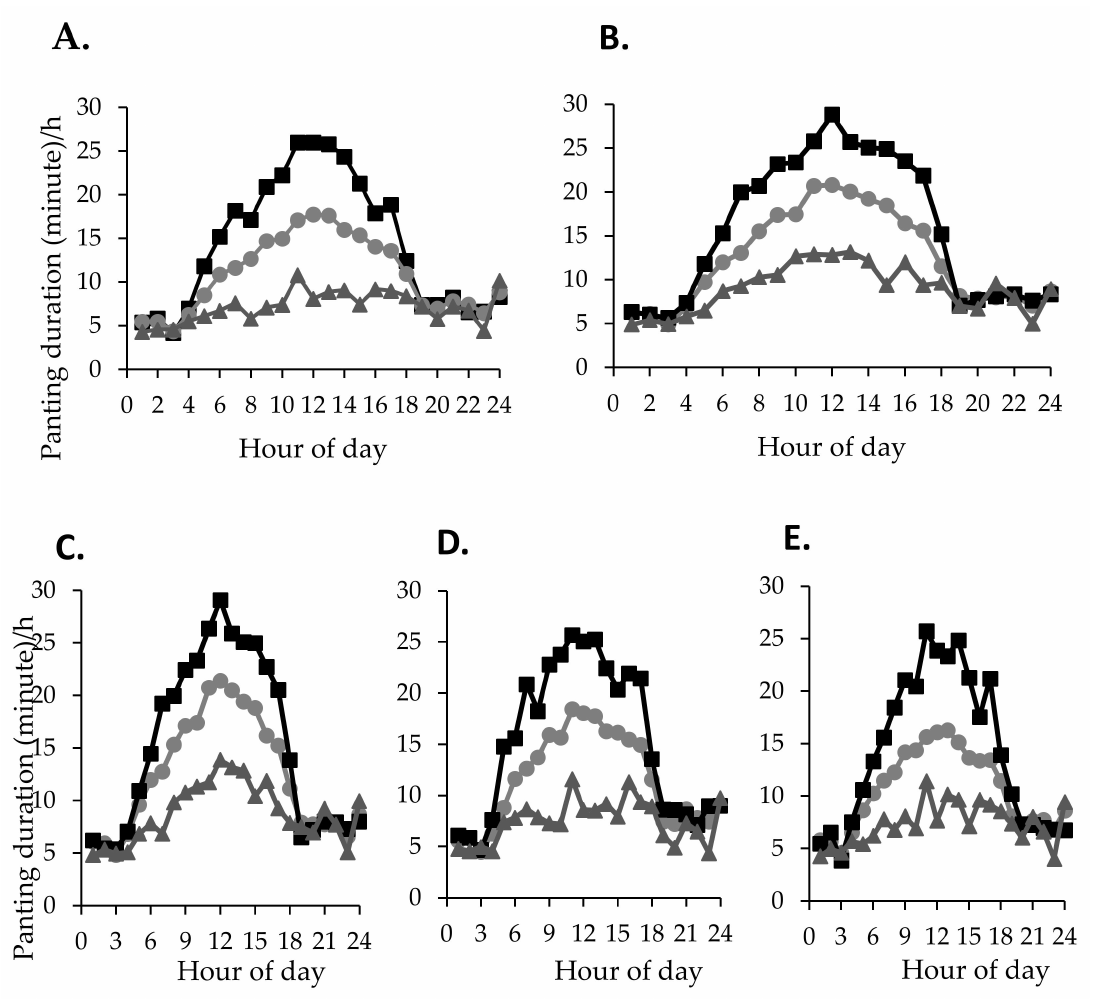
Figure 8. Mean panting duration / h of the top ( ) and bottom ( ) 10% cattle for panting within the same genotype (( A ): 50% Bos indicus and ( B ): less than 40% Bos indicus ) and coat colour (( C ): Dark, ( D ): Tan and ( E ): White) categories in comparison to their herd mean panting duration / h (